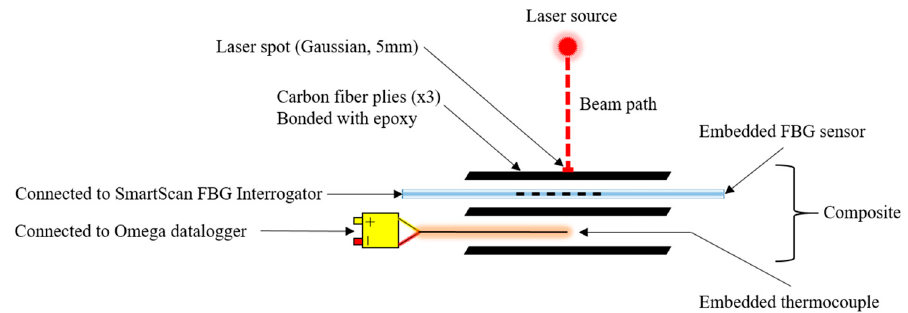
Figure 2. Arrangement of sensors embedded within a three-ply composite.